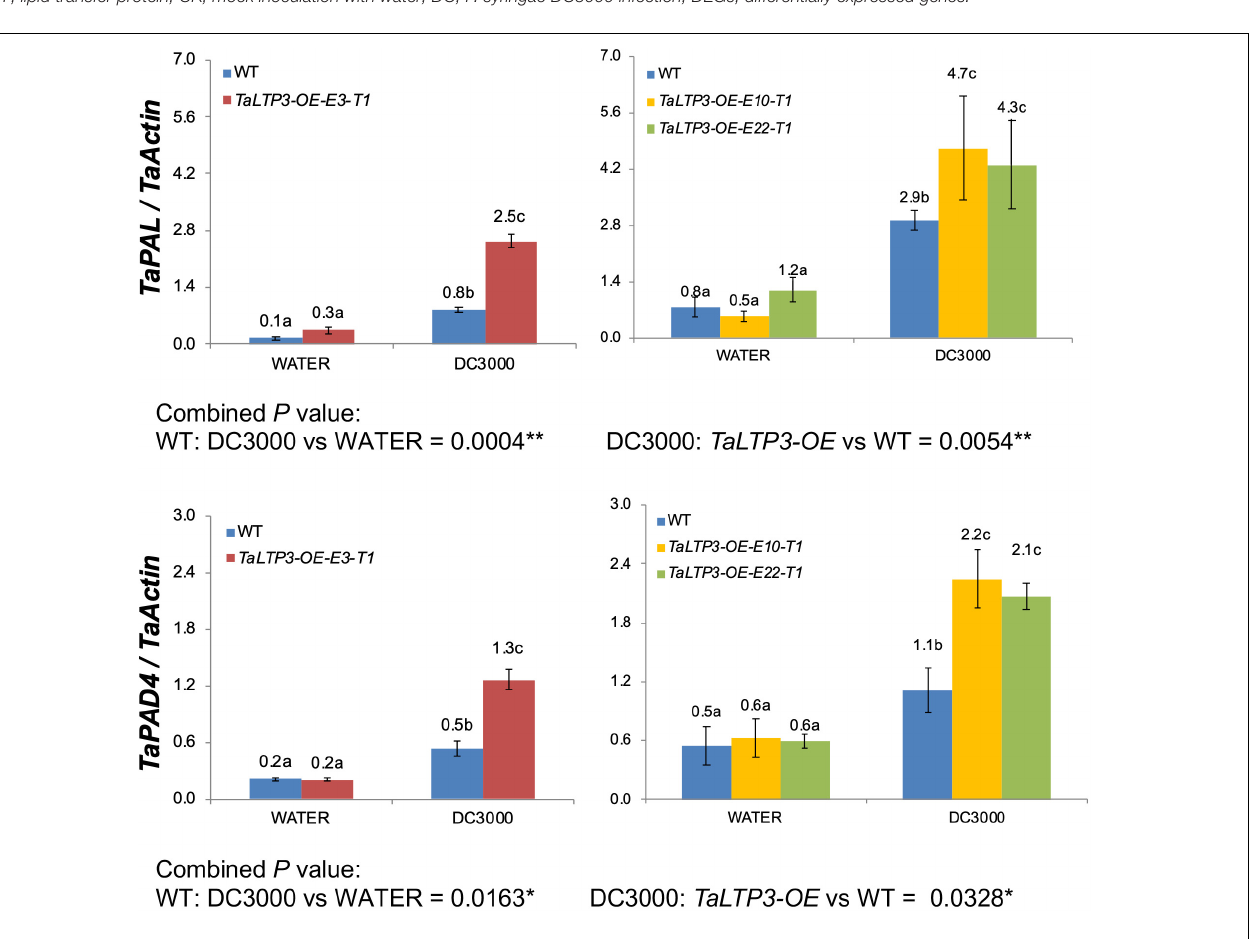
FIGURE 3 | The transcriptional levels of TaPAL and TaPAD4 were determined by qPCR in transgenic line TaLTP3-OE upon P. syringae DC3000 infection. The transcript levels for all the genes were expressed as linearized fold- TaActin levels, which were calculated based on the formula 2 ( Actin Ct − Target Ct ) . Three independent transgenic lines of TaLTP3-OE were tested. Each experiment, consisting of 4–9 biological replicates, was considered as a block. Calculations of the mean and SE were performed by using the Microsoft Excel software. Generalized linear model (GLM) ANOVA (* p < 0.05, ** p < 0.01) was conducted by using the SAS software version